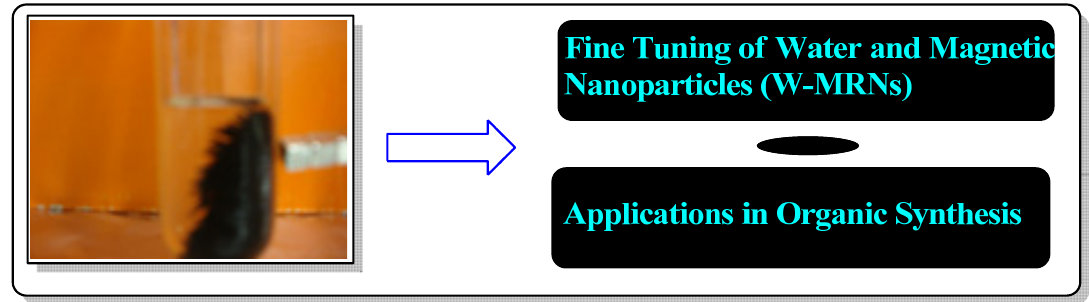
Figure 1. Tuning of water and magnetic